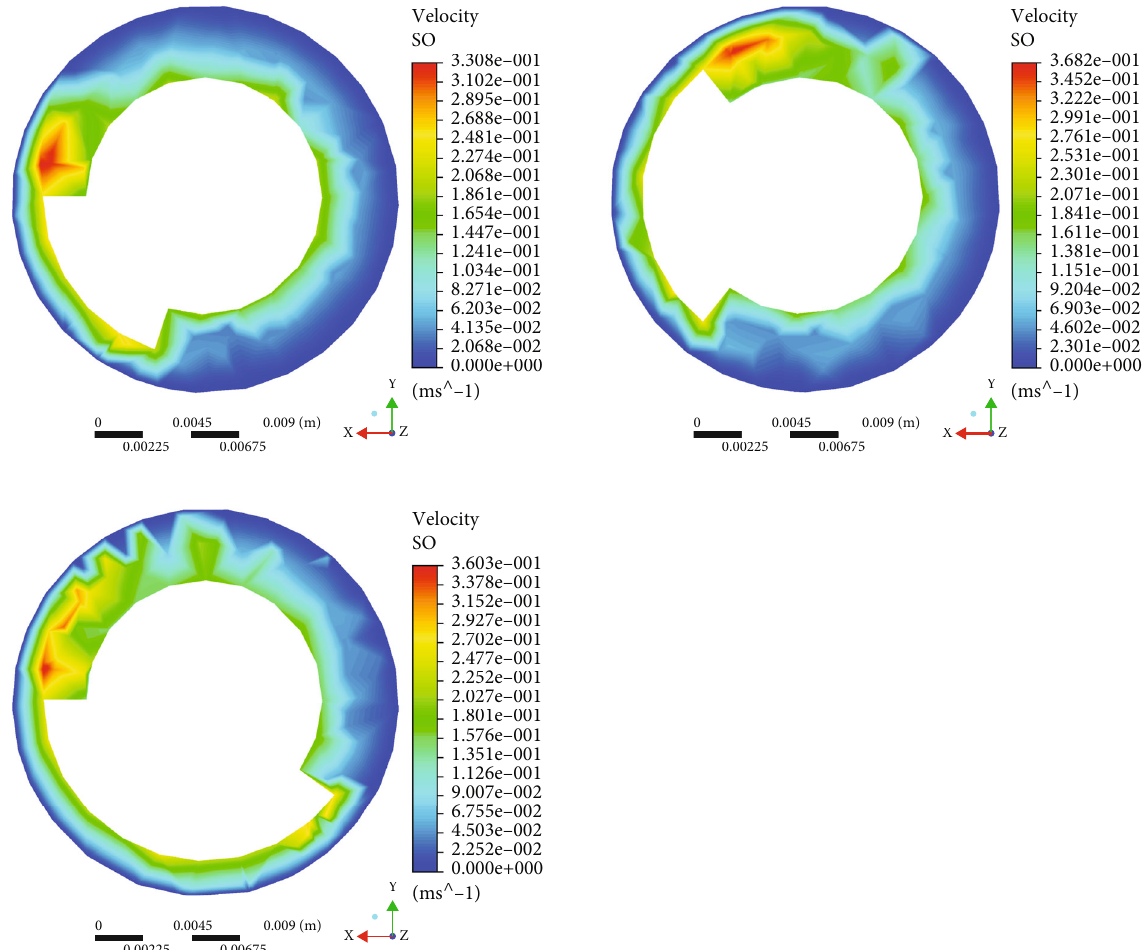
Figure 6: Simulation of exit plane velocity pro fi le of di ff erent capsule robots at the same